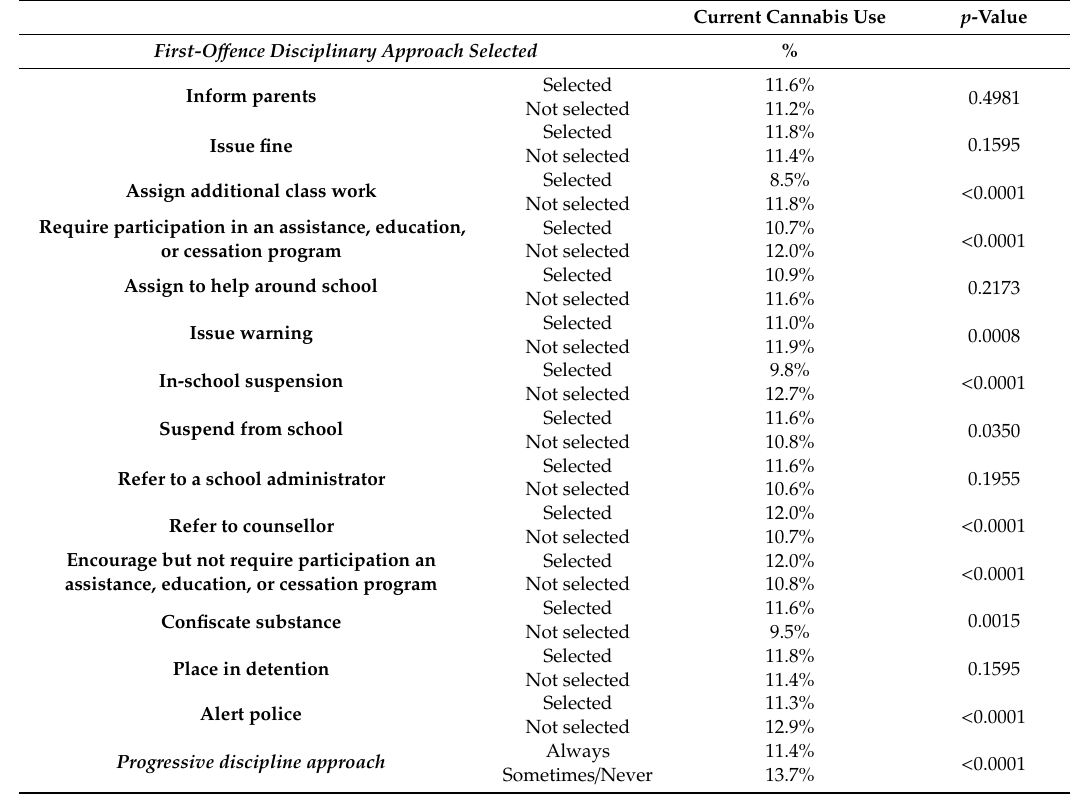
Table 5. Student cannabis use by disciplinary options selected by secondary schools as potential approaches used in response to student violations of school substance use policies in Year 6 (2017 / 2018) of the COMPASS